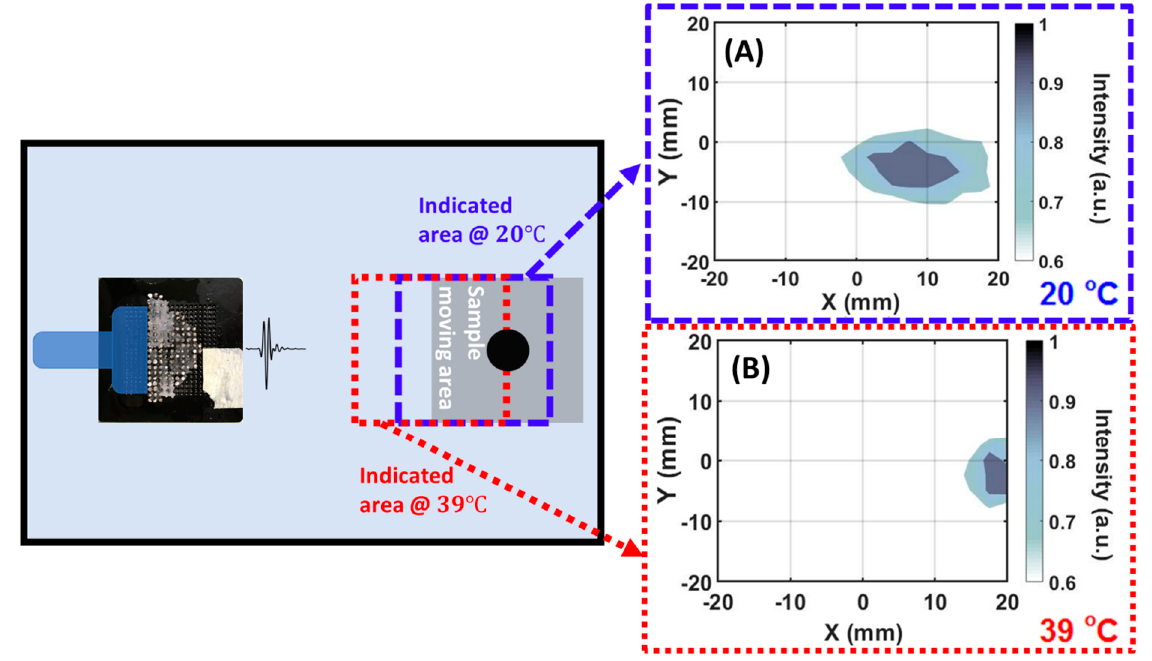
Figure 4. 2D frequency domain echo-intensity mode mappings by TSSL at 20 °C and 39 °C. A 10 mm diameter aluminum rod moved on the X - and Y -axis in a 40 mm by 40 mm area with a 2 mm interval on both axes. TSSL scanned data recorded at 20 °C ( A ) and 39 °C ( B ) with the sample moving in the same area.